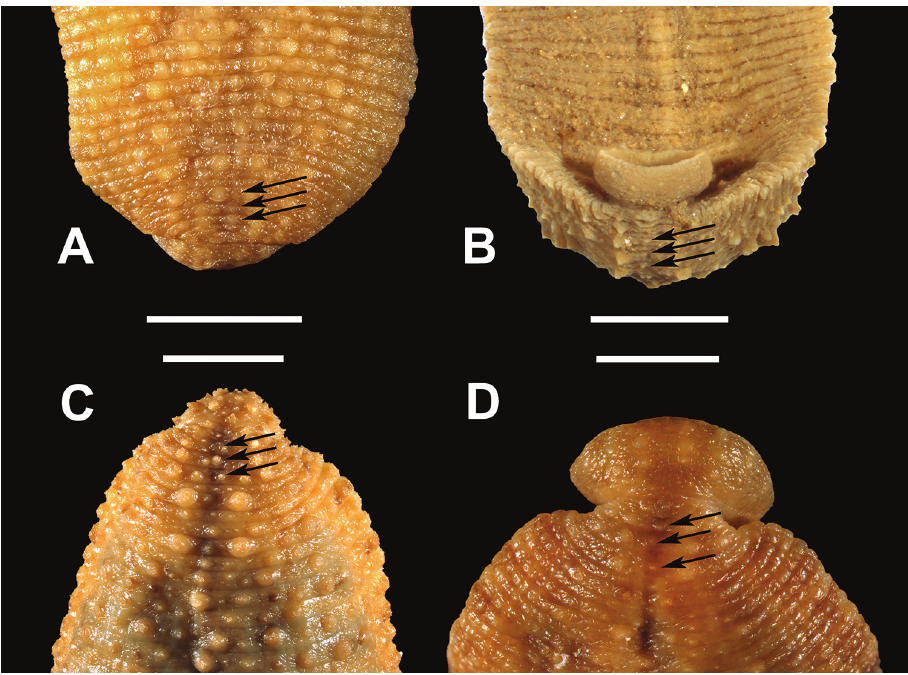
Figure 4. Dorsal surface, anal region. Medial row of small but distinct papillae (indicated by arrows) lying between the anus and commencement of prominent paramedial papillae, on A Placobdella ru- gosa (YPM IZ 083787) B Placobdella ornata , syntype (YPM IZ 000256) C Placobdella ali (YPM IZ 058254) D Placobdella multilineata (YPM IZ 083782). Scale bars: 3 mm ( A ), 1 mm ( B ), 4 mm ( C ), 2 mm ( D